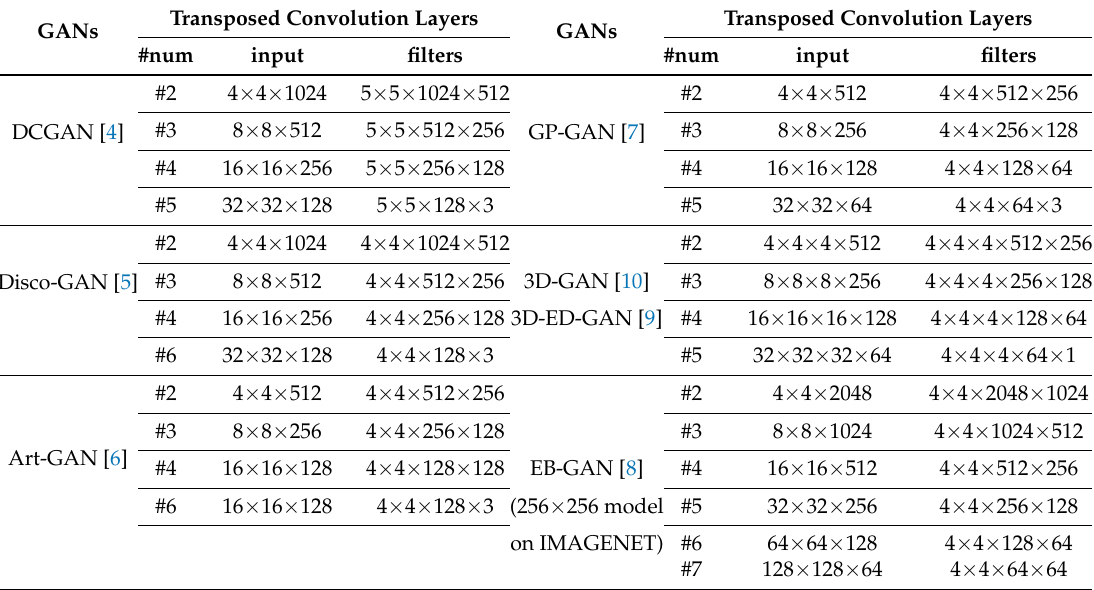
Table 4. Design configurations of GANs.